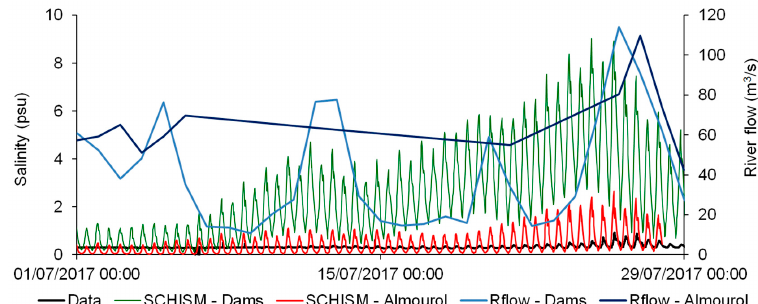
Figure 6. Validation of the salinity model in the upper reaches of the estuary (Conchoso station) and for low river flow conditions. Two alternative input river flows were considered: measured at Almourol, and the sum of the outflow from the two dams that discharge into the lower Tagus River. Regarding the upstream bathymetry, results show that the differences between the two simulations are minor (Figure 7), with mean absolute difference smaller than 0.1 psu (range 0–0.7